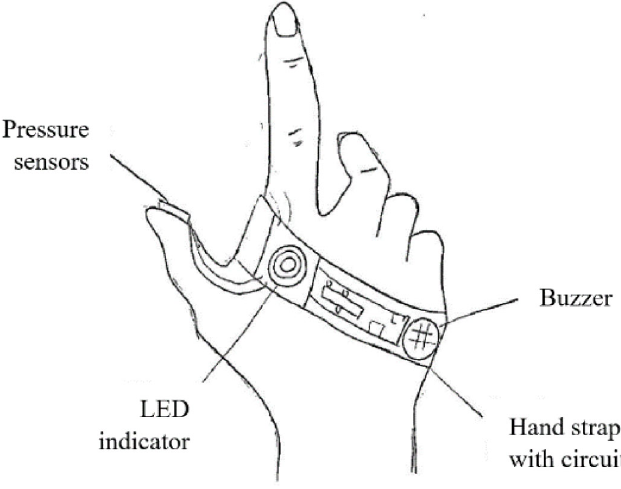
Figure 7. Mechanics substitution/another sense and taking out concept